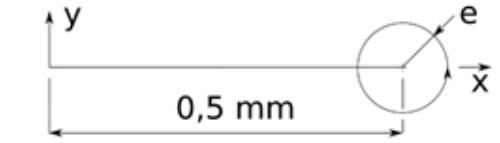
Fig. 2. Eccentric motion Combinations of deviation amplitudes and mean values of eccentricities are shown in Table 1. Table 1. Combination of eccentricity and deviation Mean value of